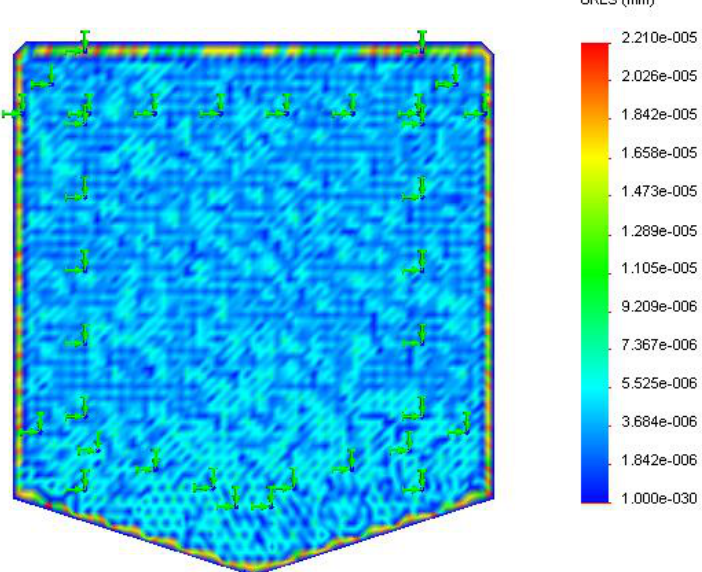
Table 6. Maximum displacement in the deformation analysis.